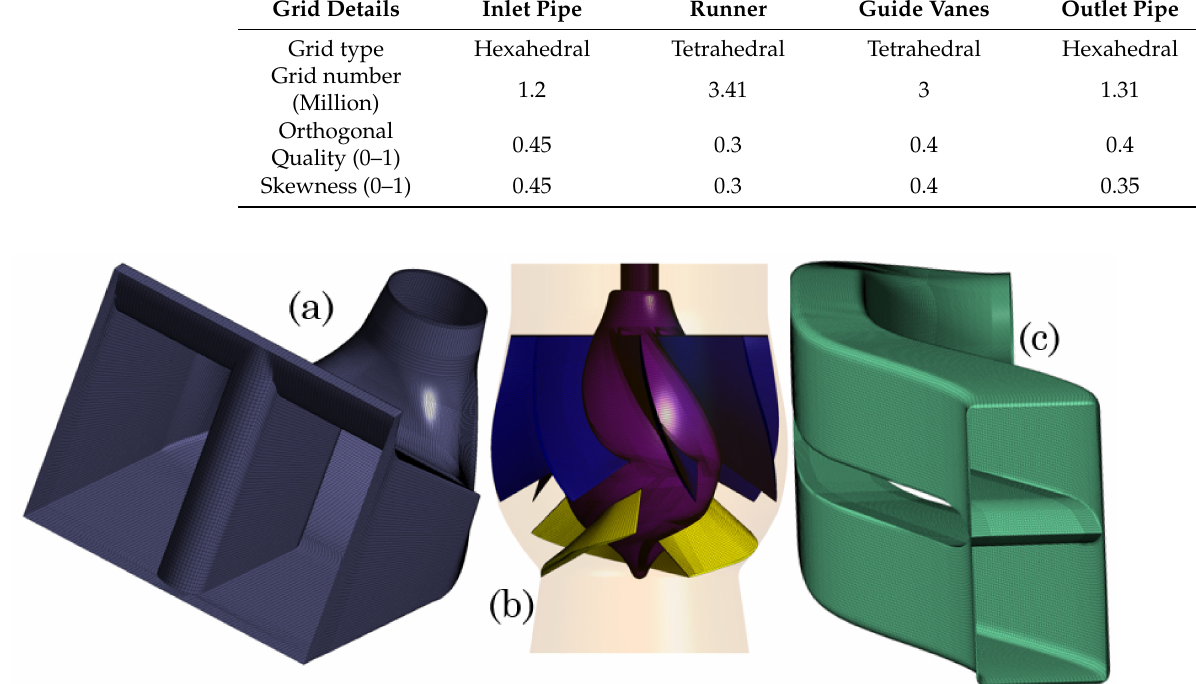
Figure 6. Selected grid for different model components ( a ) inlet pipe, ( b ) diffuser and runner, and ( c ) outlet